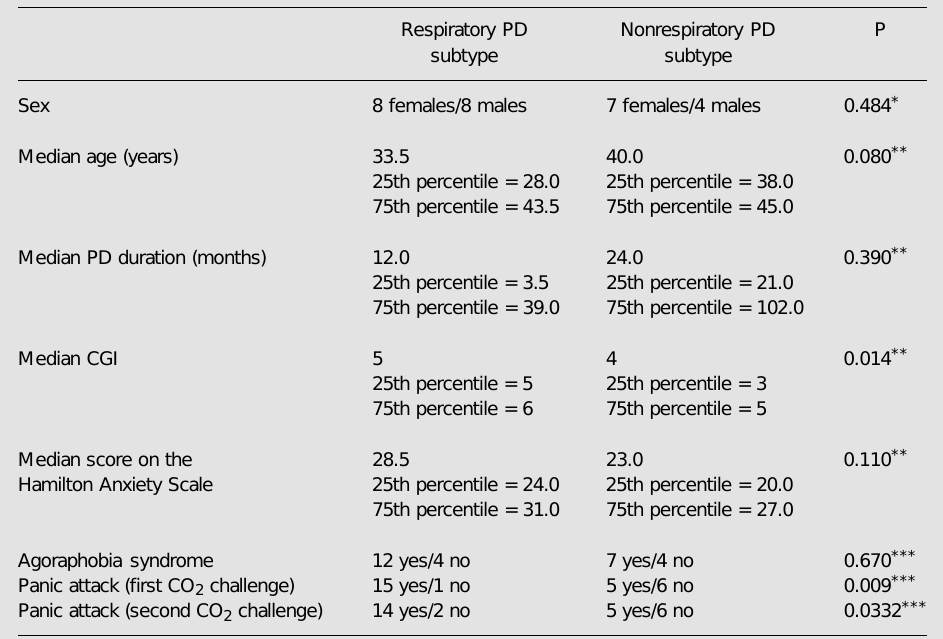
Table 1. Clinical and demographic data of the patients (N =